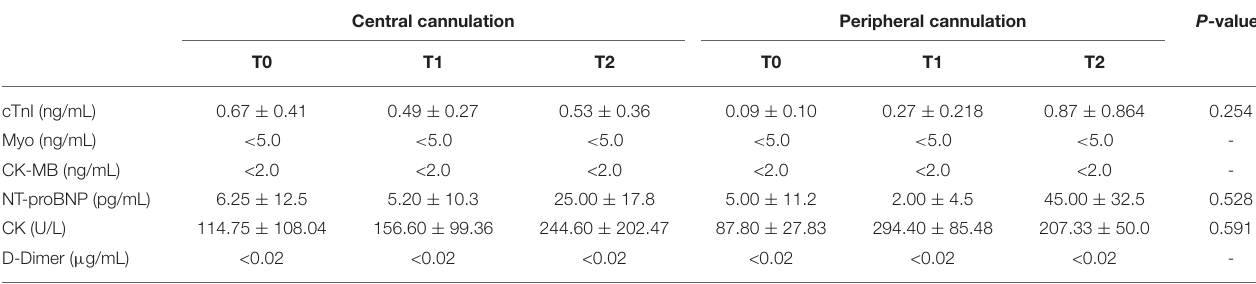
TABLE 1 | Myocardial enzyme and D-dimer levels.